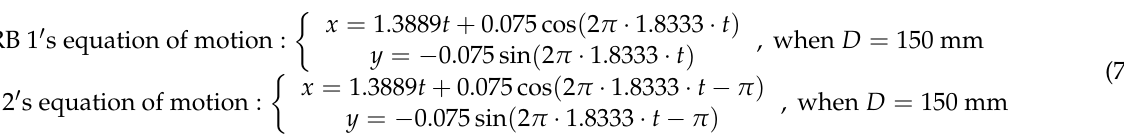
9 of 20 Figure 5. The motion trajectory of the tip of the SRB at different D values. Note: D is the ODRD, mm; n is the RVSS, rpm; v is the operating velocity of machines, km/h. In order to describe the motion law of the SSM more clearly, the two sets of SRB in green are expressed as the blue SRB 1 and the yellow SRB 2. 3.1.1. Analysis When the ODRB D = 150 mm Firstly, some necessary basic parameters needed to be determined. When the ODRB D was taken as 150 mm, it could be determined from Equation (2) that S = D = 150 mm, then k = b /2 S = 0.3. Considering that the number z of turns of the RBs was z ≥ k = 0.5, and when the number of groups of SRB was 2, there was z ≤ 0.5 (each group was assigned at most 180°), so the number of turns of the RBs was z = 0.5. Secondly, determine the kinematic equation of the SSM. The operating velocity v of machines took the maximum operating velocity, that was, v = 5 km/h = 1.3889 m/s. The ODRB was D = 150 mm = 0.15 m. The RVSS n was fixed at 110 rpm (the law analysis and